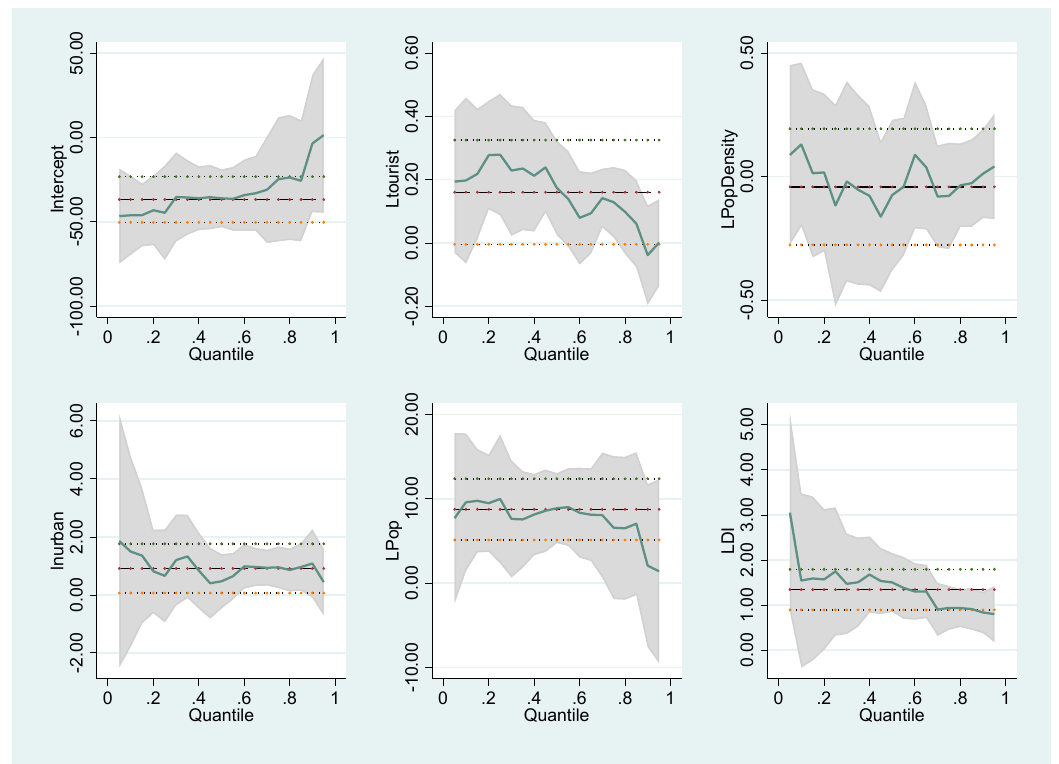
Figure 1. Changes in the quantile regression coefficients for Model I. Notes: The shaded bands represent the corresponding 95% confidence intervals.